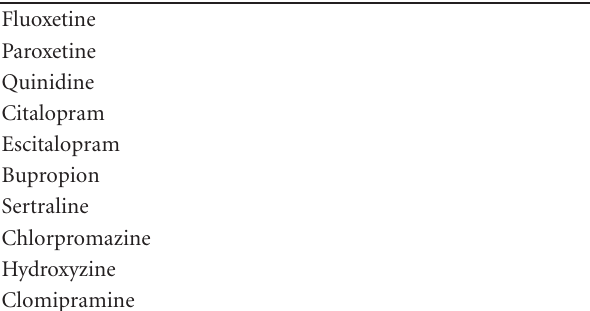
Table 2: Some of the commonly used drugs that inhibit the Cyto- chrome P450 (CYP2D6) system [3, 6,